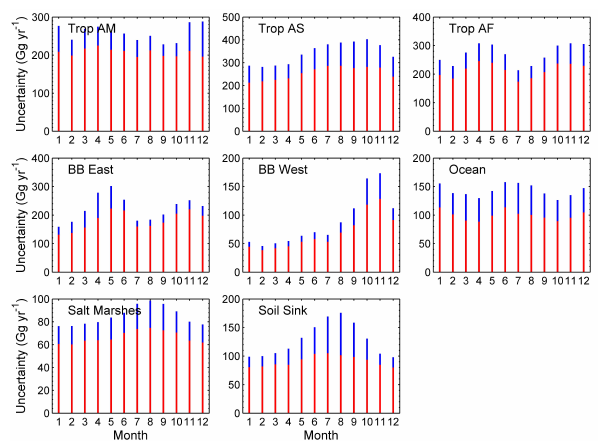
Fig. 8. Five-year averaged results for the 8 seasonally varying emis- sion processes of CH 3 Cl. Blue lines show the reference magnitudes. Red lines show the optimized estimates.